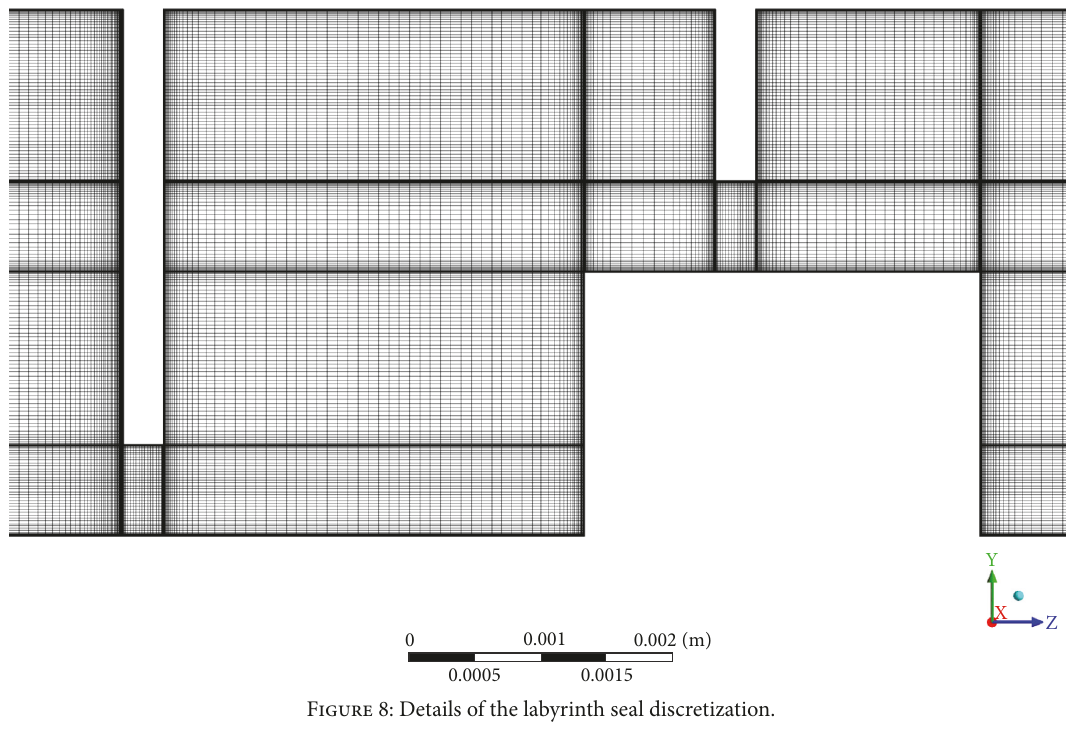
Figure 8: Details of the labyrinth seal discretization.